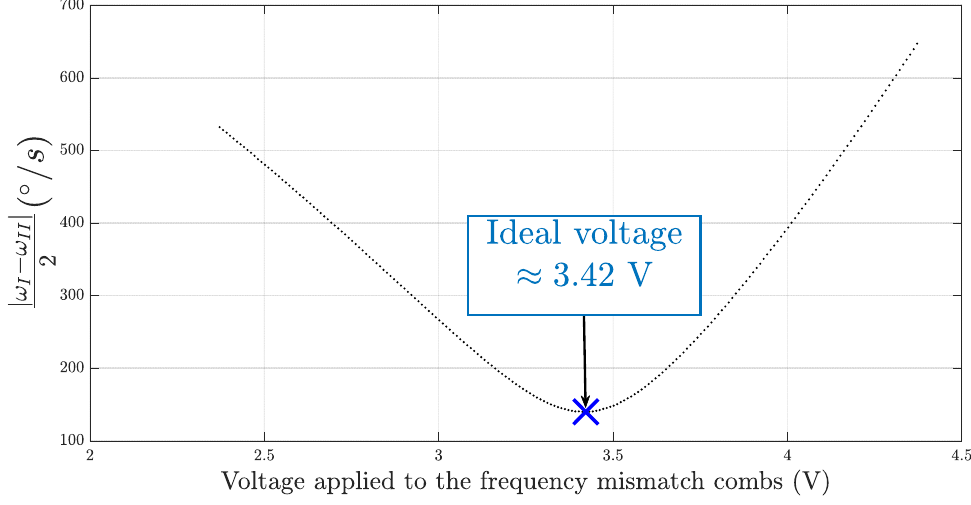
Figure 10. Frequency mismatch minimization experiment on gyroscope n°1.